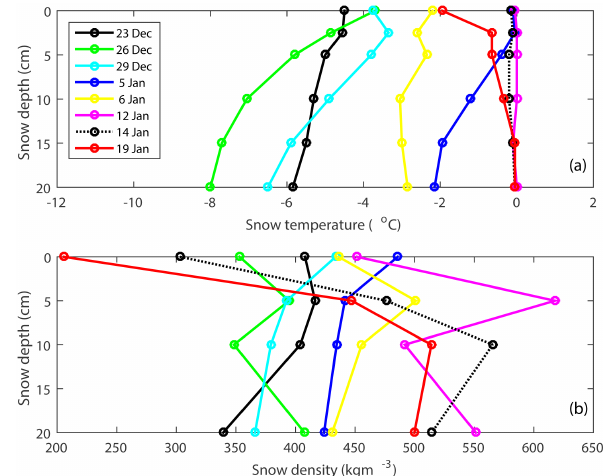
Figure 2. Vertical profiles of snow temperature and density in the uppermost 20cm of the snowpack for the analyzed clear and over- cast cases. Each profile results from the average of two almost si- multaneous profiles, taken 0.4m apart. The surface density mea- surements were taken with a 2cm-tall sampler, and therefore rep- resent an average of the uppermost 2cm of the snowpack. At the deeper layers, the snow density samples were taken using cylinders with axes centred at 5, 10, 15, and 20cm